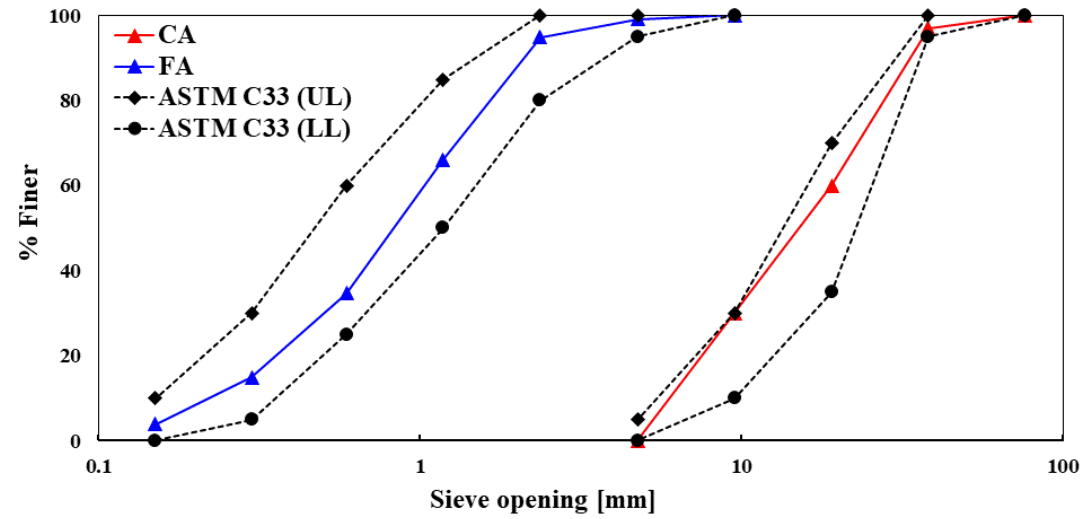
Figure 2. Grading curve of coarse aggregate (CA: BA and SSA) and fine aggregate (FA), and comparison with the upper limit (UL) and lower limit (LL) recommended in ASTM C33 standard [20].